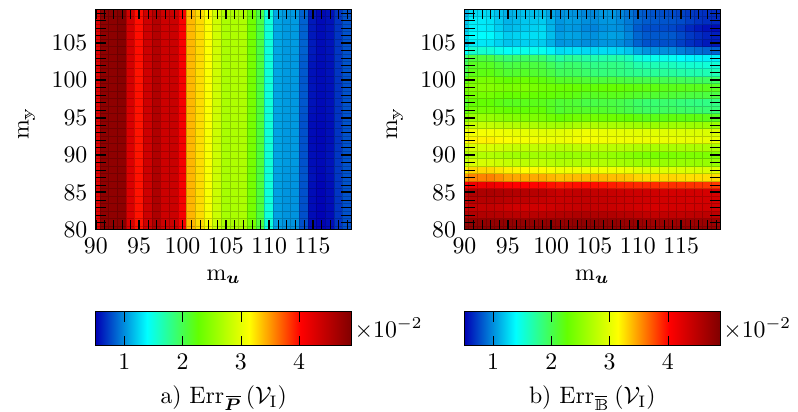
Figure 9. Output error analysis for varying numbers of elements m u and m y constituting the reduced meshes and built using n P = 120 stress and n B = 100 induction modes for a reduced basis of E u E y size n u = 20 and n y = 10.